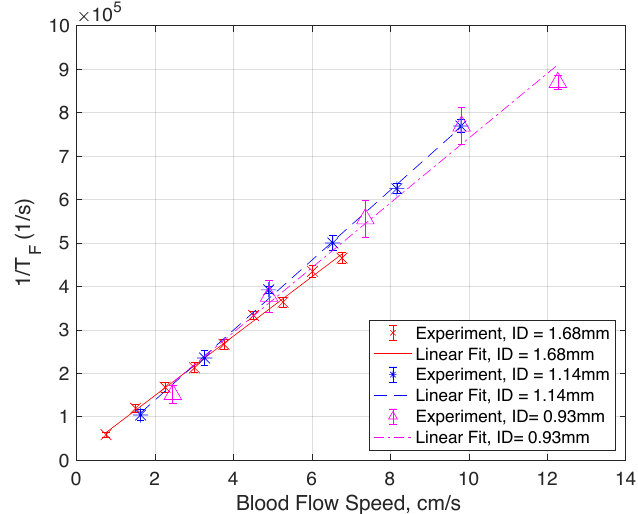
Figure 5. Combined decorrelation rate (1/ T F ) versus blood flow speed plot for different tube ID. The scattered data set with the error bar represents the 95% confidence interval over 25 measurements, each for a duration of 1 s. The line plots are linear fits of the measured data. The fact that plots for different tube IDs collapse into one single line demonstrates the existence of a simple relation between the decorrelation rate and the blood speed, and the relation is independent of the tube